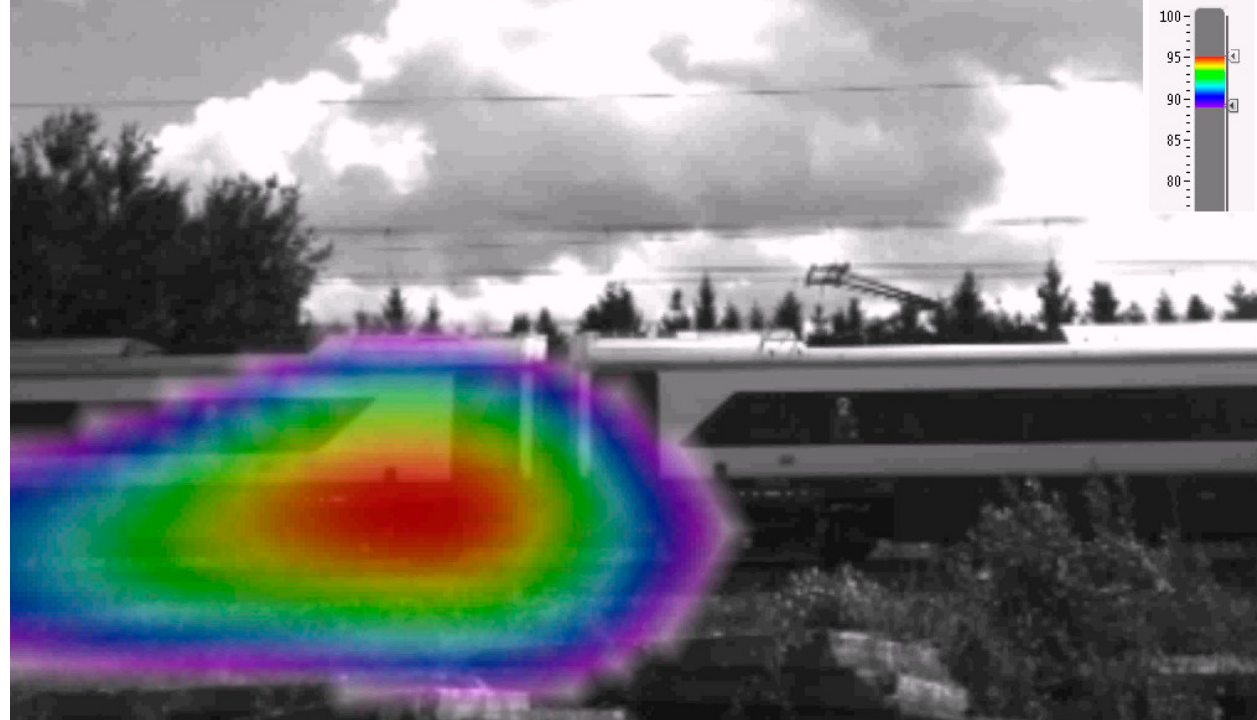
Figure 10. Sound level distribution within a frequency range of 500–1000 Hz—straight section .